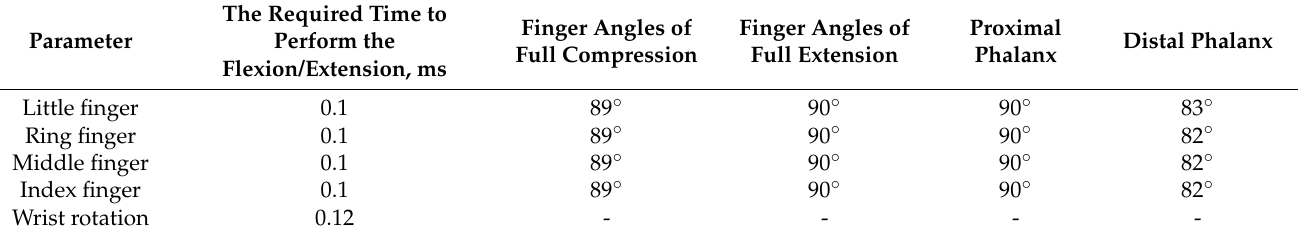
Table 3. The experimental results for the angular displacements and the required time of each finger and wrist of anthropomorphic robotic arm.